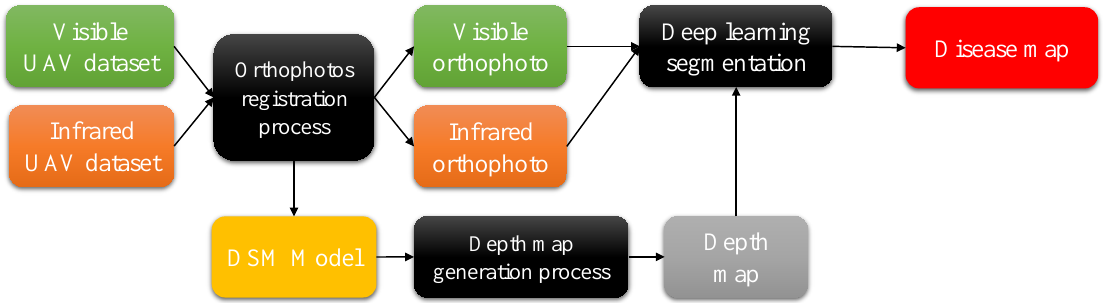
Figure 1. The proposed vine disease detection